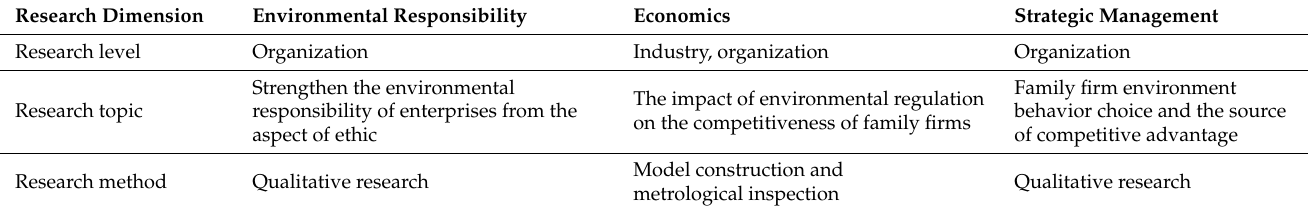
Table 1. Comparative study on the environmental behavior of family enterprises in different